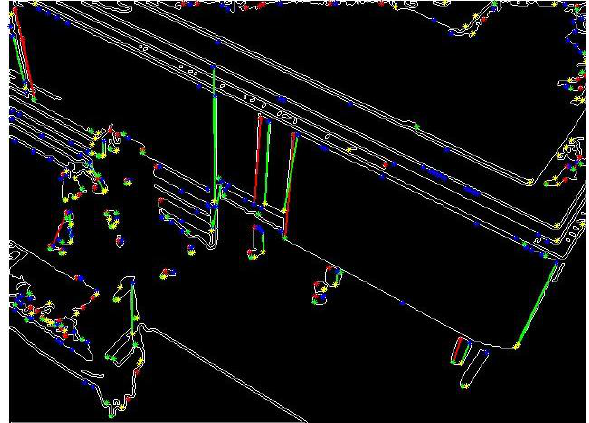
Figure 8. The extracted corners and Vertical Line Features Given that the scales of the synthetic image and the video from the edge image of the video frame frame are similar, the horizontal spacing between the vertical lines should be similar as well. Thus, a horizontal shift should Many „false corners‟ were detected in the video image. These align both sets of vertical lines. This shift is evident in Figure 10, where for each Vertical Line Feature the column value of the line‟s centroid is plotted against the length of the same line. The red series signifies the lines extracted from the video frame, and the green series corresponds to the lines from the synthetic image. The triangles symbolize Left Vertical Line Features, and squares symbolize Right Vertical Line Features. The maximum value of the cross correlation of the red (video) series and green (model) series provides the numerical value of the horizontal shift. length. Figure 11 shows the lines from the video images with the shifted lines from the synthetic image. Potential Vertical Line Feature matches are